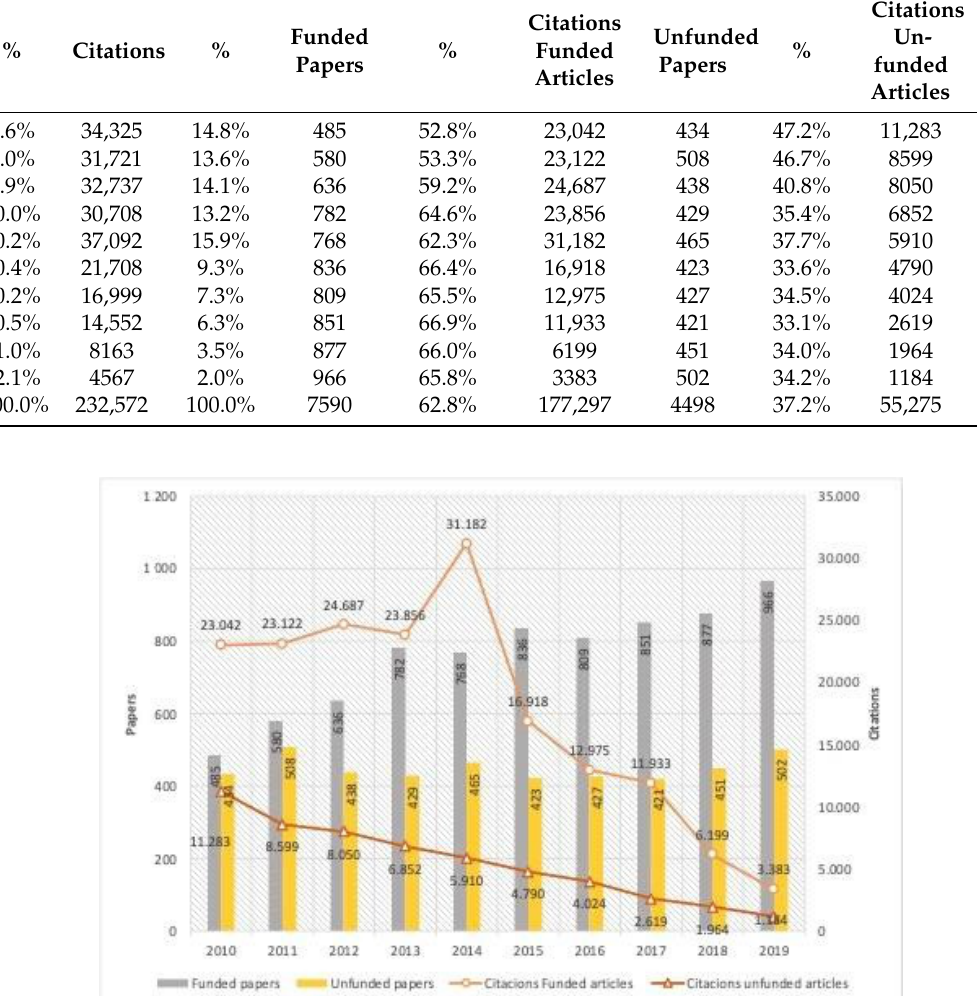
Table 1. Annual evolution of papers and citations.